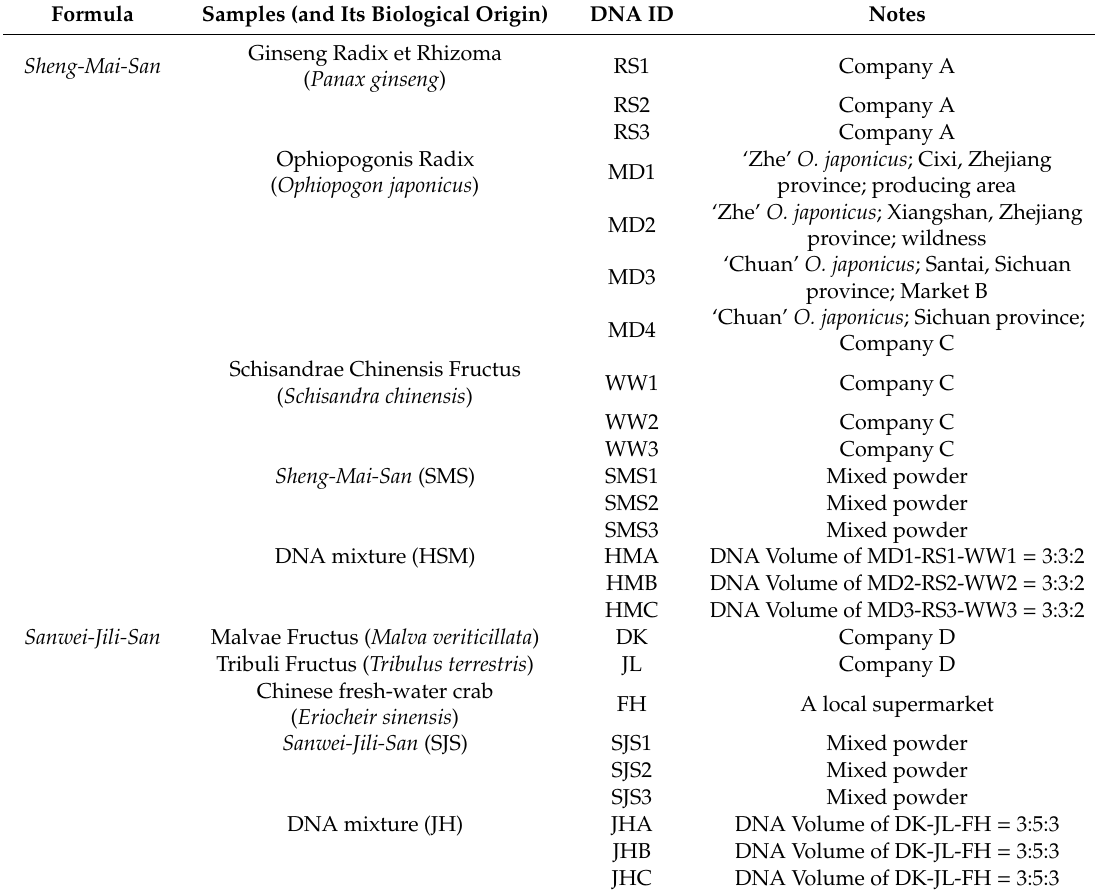
Table 1. Preparation of the DNA samples and their information.